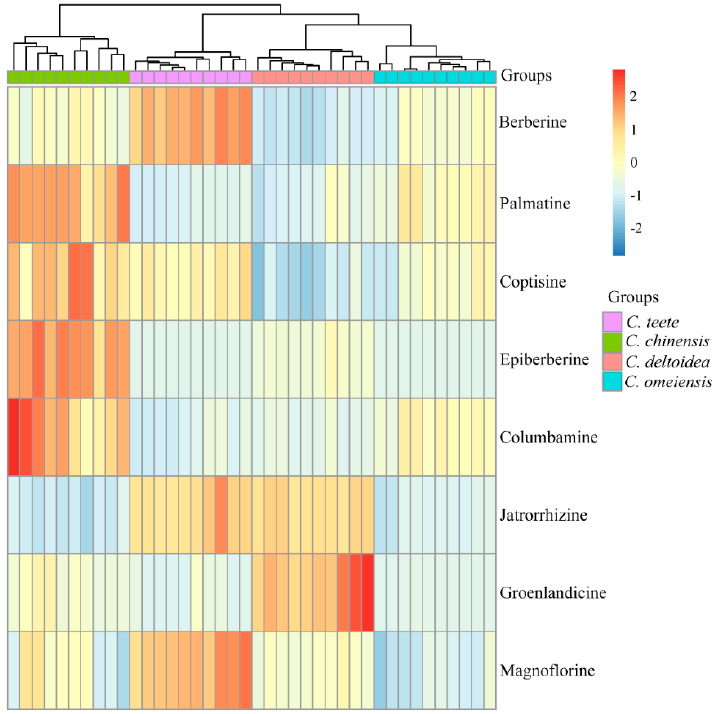
Figure 4. Result of HCA according to the concentration of eight alkaloids.